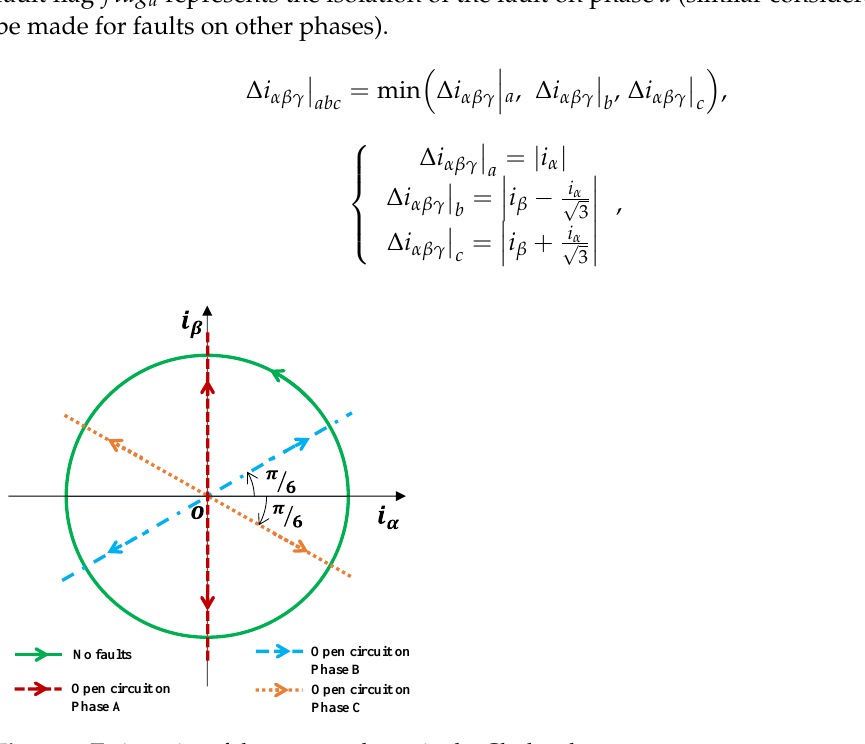
Figure 5. Trajectories of the current phasor in the Clarke plane.